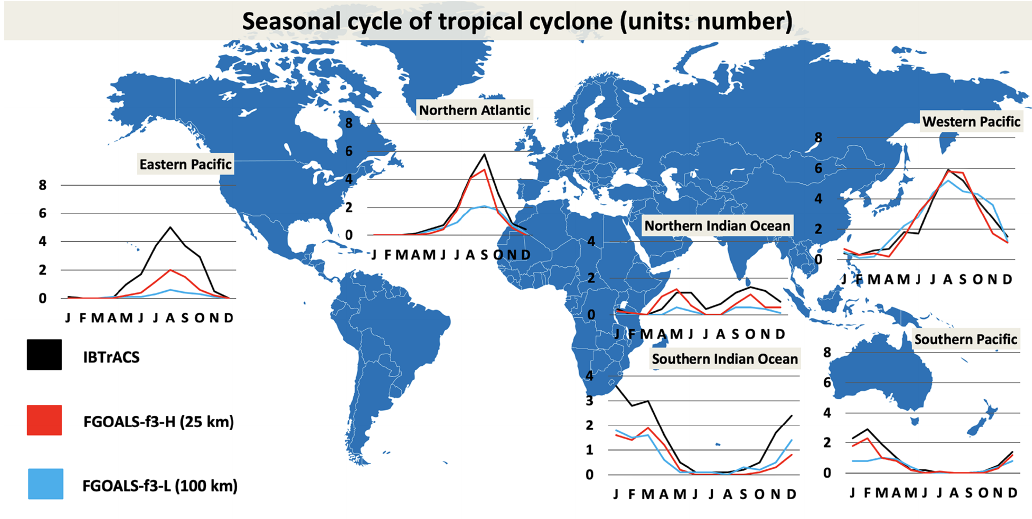
Figure 6. Seasonal cycle of tropical cyclones in the western Pacific, southern Pacific, northern Indian, northern Atlantic, eastern Pacific and southern Indian oceans (units: number of cyclones) during the time period 1991–2014.